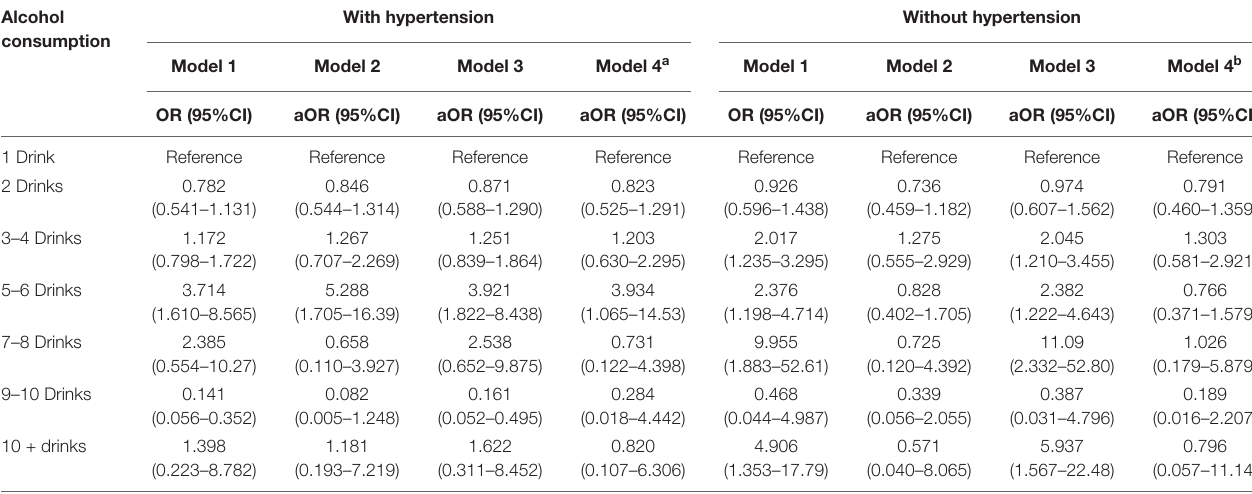
TABLE 2 | Odd ratio for cognitive impairment by different alcohol consumption categories–stratified by hypertension.